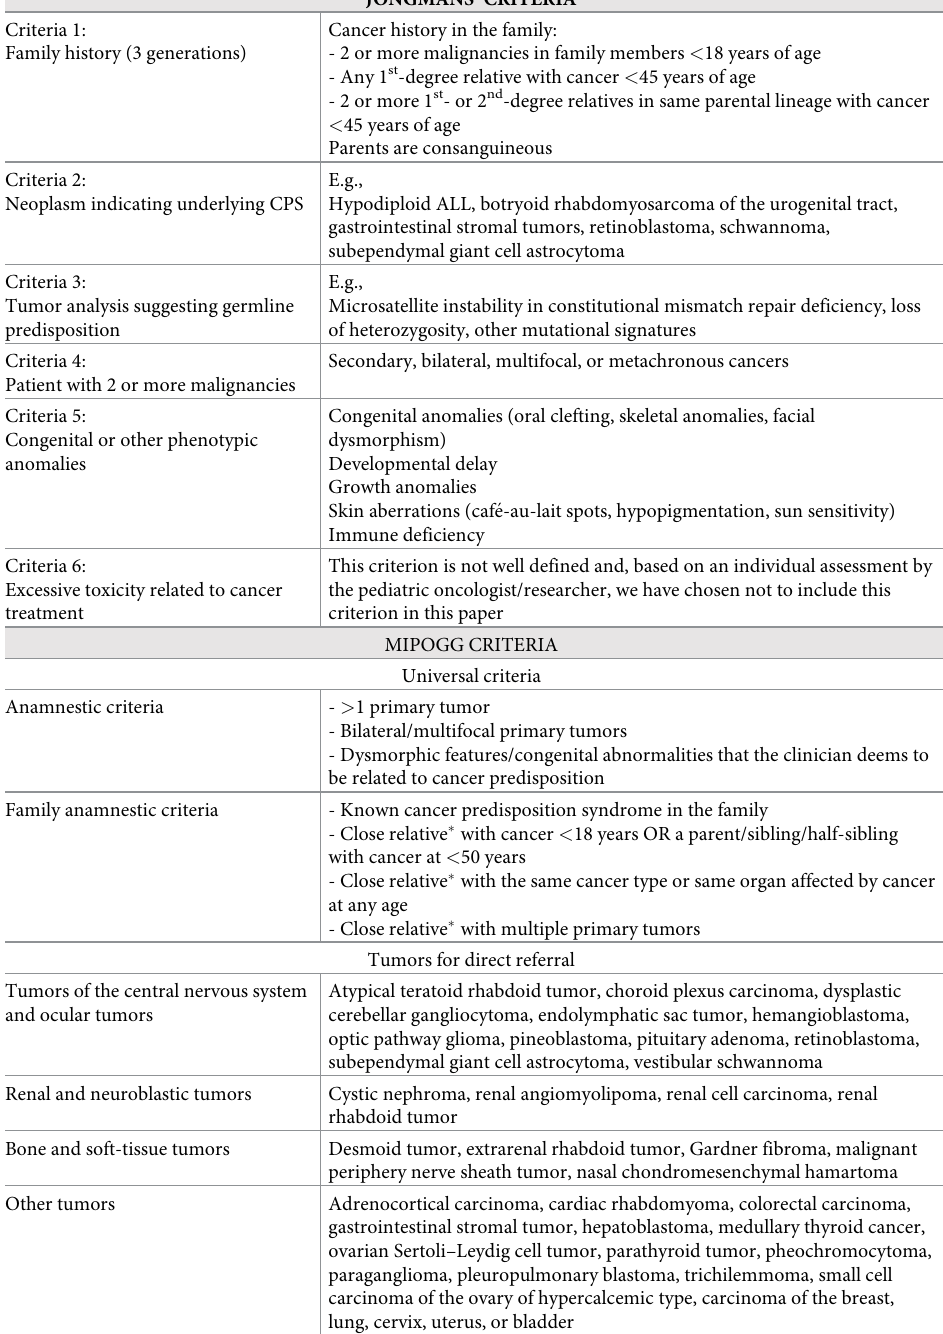
Table 1. Tools to identify patients at risk of a cancer predisposition syndrome. Excerpt from the updated Jong- mans’ criteria[13] and McGill Interactive Pediatric OncoGenetic Guidelines (MIPOGG)[17]. JONGMANS’